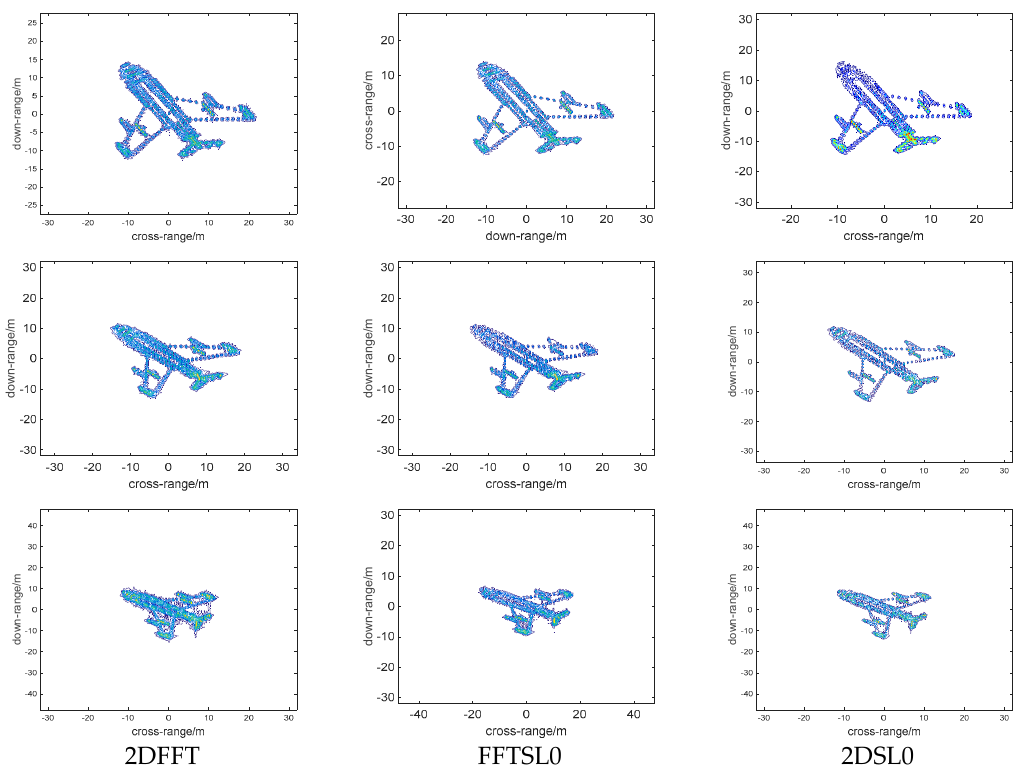
Figure 5. Bi-ISAR (Bistatic ISAR) imaging results with different reconstruction methods versus bi-angle. Column 1 represents 2DFFT images, Column 2 represents FFTSL0 images, and Column 3 represents 2DSL0 images. Row 1 represents bi-angle 60°, Row 2 represents bi-angle 90°, and Row 3 represents bi-angle 120°.